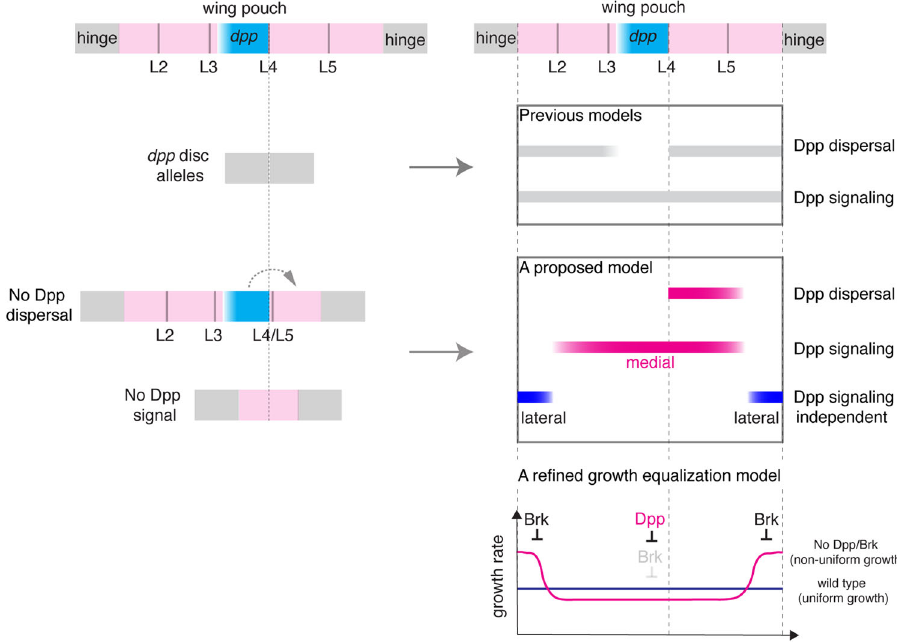
Fig. 9 Asymmetric requirement of Dpp dispersal for wing patterning and growth, and a re fi ned growth equalization model. Based on complete lack of wing pouch in dpp disc alleles, it has long been thought that Dpp dispersal from the anterior stripe of cells controls the overall patterning and growth of the Drosophila wing pouch. In contrast, the present study shows that while critical for the posterior patterning and growth, Dpp dispersal is largely dispensable for the anterior patterning and growth. The asymmetric requirement of Dpp dispersal is in part due to dpp transcriptional re fi nement from an initially uniform to a localized expression and persistent signaling in transient dpp source cells. Furthermore, despite a critical requirement of Dpp signaling for the medial wing pouch growth, Dpp signaling is dispensable for the lateral wing pouch growth after wing pouch speci fi cation. We propose a re fi ned growth equalization model, in which Dpp signaling removes a growth repressor Brk to allow medial regions to grow, while Dpp signaling sets Brk expression to the lateral region to repress the lateral growth with higher growth rate to equalize growth rates. In this re fi ned model, both the Dpp signaling-dependent medial region and -independent lateral region exist within the wing